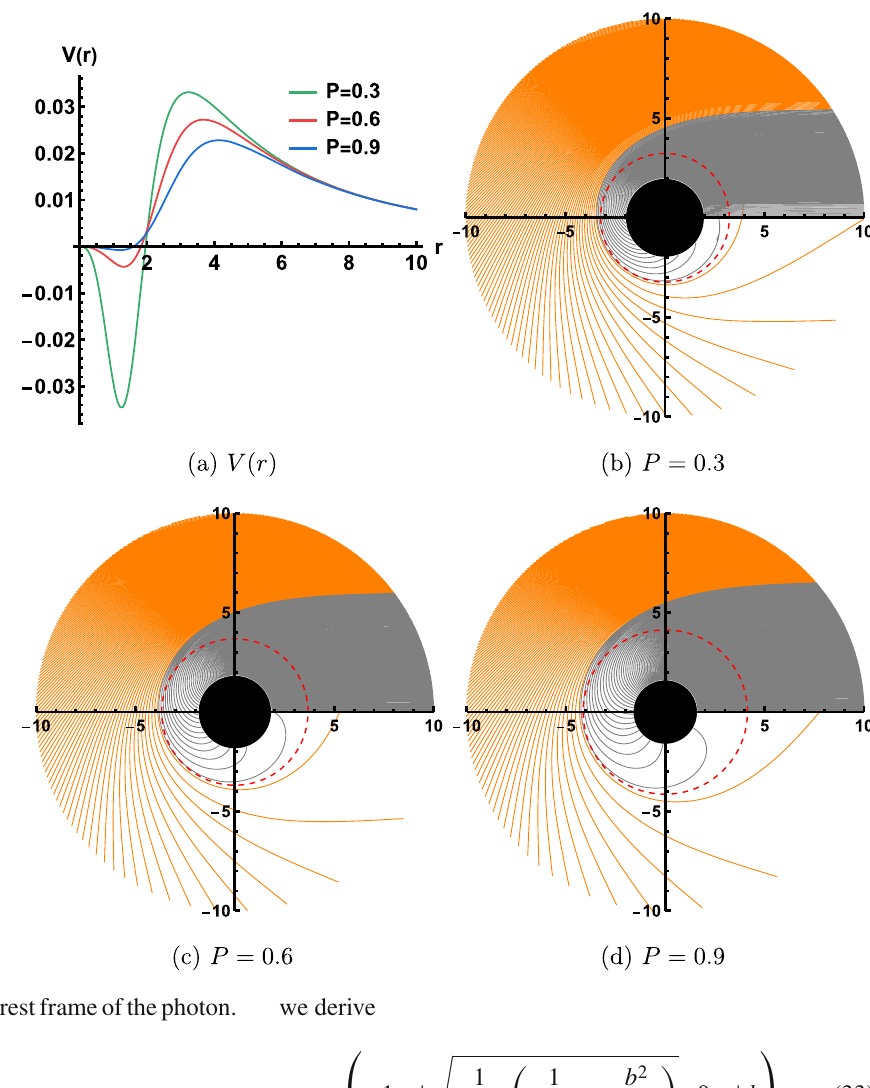
Fig. 4 The effective potential V ( r ) for different magnetic charges P are shown in the top-left panel. The other figures are trajectories of photons for different values of P with fixed β = 0 . 1 and M =